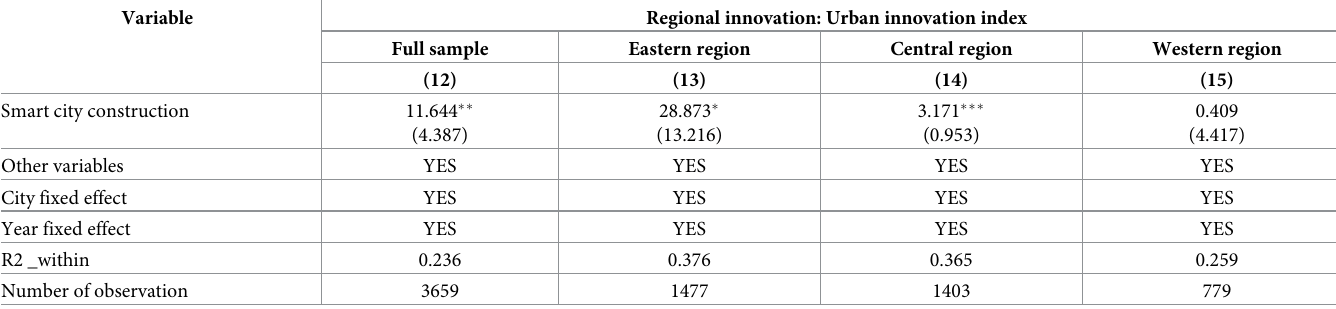
Table 5. The regression results of regional innovation measured by urban innovation